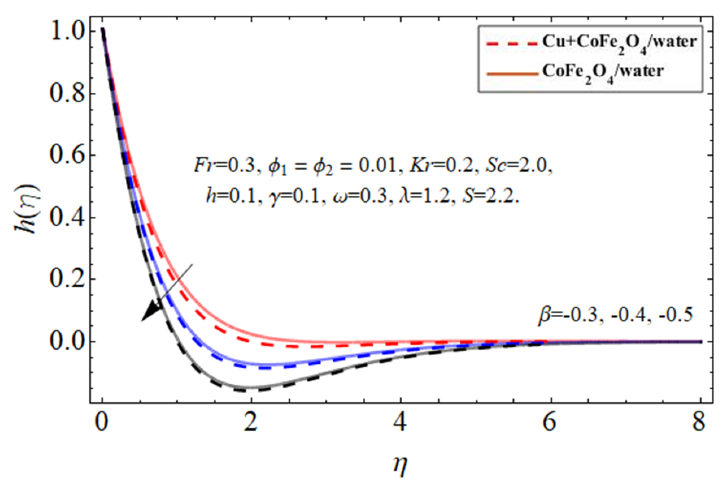
Micromachines 2023 , 14 , 48 10 of 16